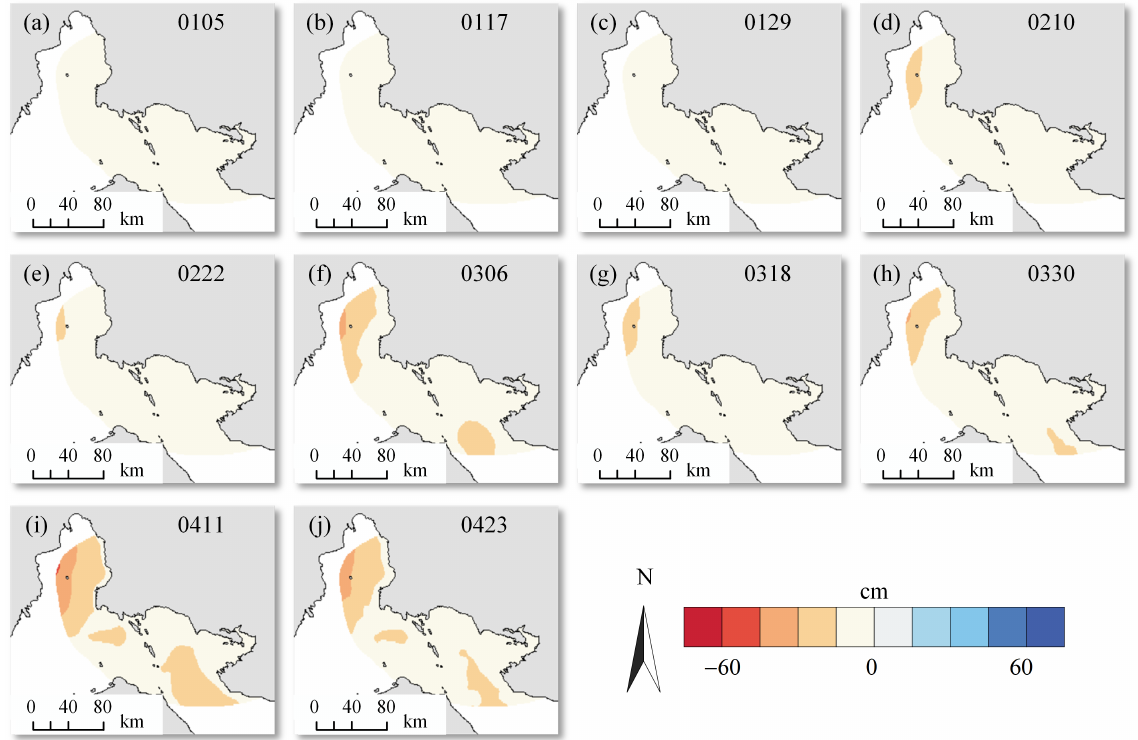
Figure 11. Retrieved time-series vertical deformation from January 2021 to April 2021: the top-right number of subfigures ( a – j ) represents the corresponding SAR images acquisition